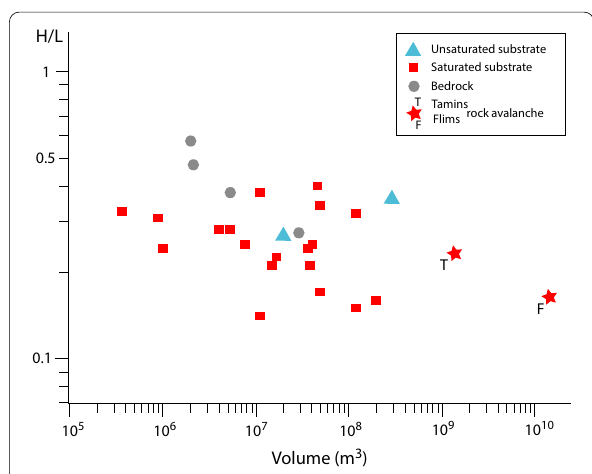
Fig. 26 H/L ratio versus volume (V) of rock avalanches. Data from Aaron and McDougall (2019) complemented with the Flims (F) and Tamins (T) rock avalanches. H: drop height, L: travel distance along